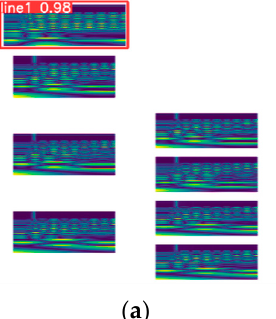
( c ) Figure 16. Grounding fault that occurred in Line 1: fault distance of ( a ) 2 km; ( b ) 4 km; ( c ) 6 km.